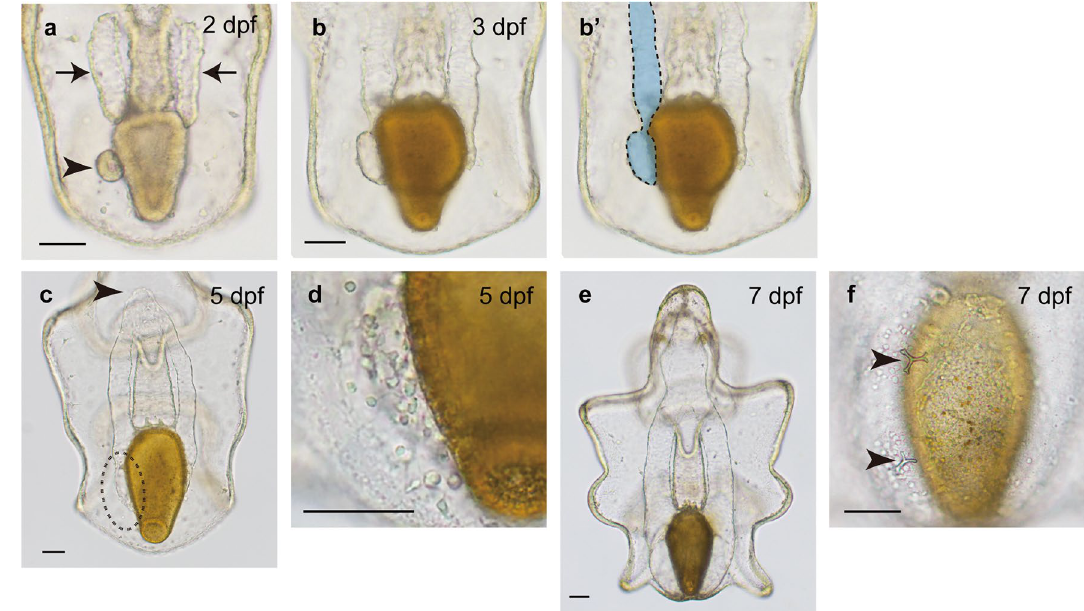
Figure 1. Observation of coeloms and skeletogenic mesenchyme cells in the starfish Patiria pectinifera . Bipinnaria larvae at 48 h postfertilization (hpf) possess two types of coeloms: a posterior enterocoel (PE, arrowhead in a) and two bilateral coelomic pouches (arrows in a ). After the onset of feeding, the bilateral coelomic pouches extend posteriorly along the lateral walls of stomach, and the left coelomic pouch and PE fuse ( b ; the left coeloms are shown in blue encircled by dotted lines in b’ ). At 5 days postfertilization (dpf), the bilateral coeloms fuse around the pharynx (arrowhead in c ), and a mesenchyme cell population appears in the dorsal posterior region (dotted circle in c ; d , enlarged image). By 7 dpf, adult skeletal rudiments first emerge on the dorsal left side ( e ; arrowheads in f ). Scale bars: 50